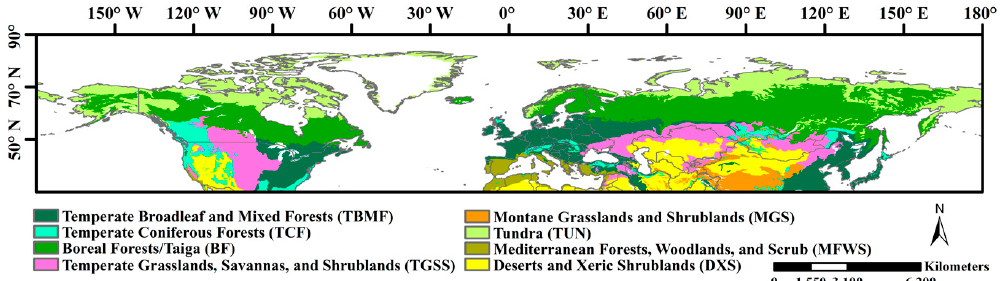
Figure 1. Study area and the distribution of biome types. The land cover classification map was obtained from the Olson et al. [33] .